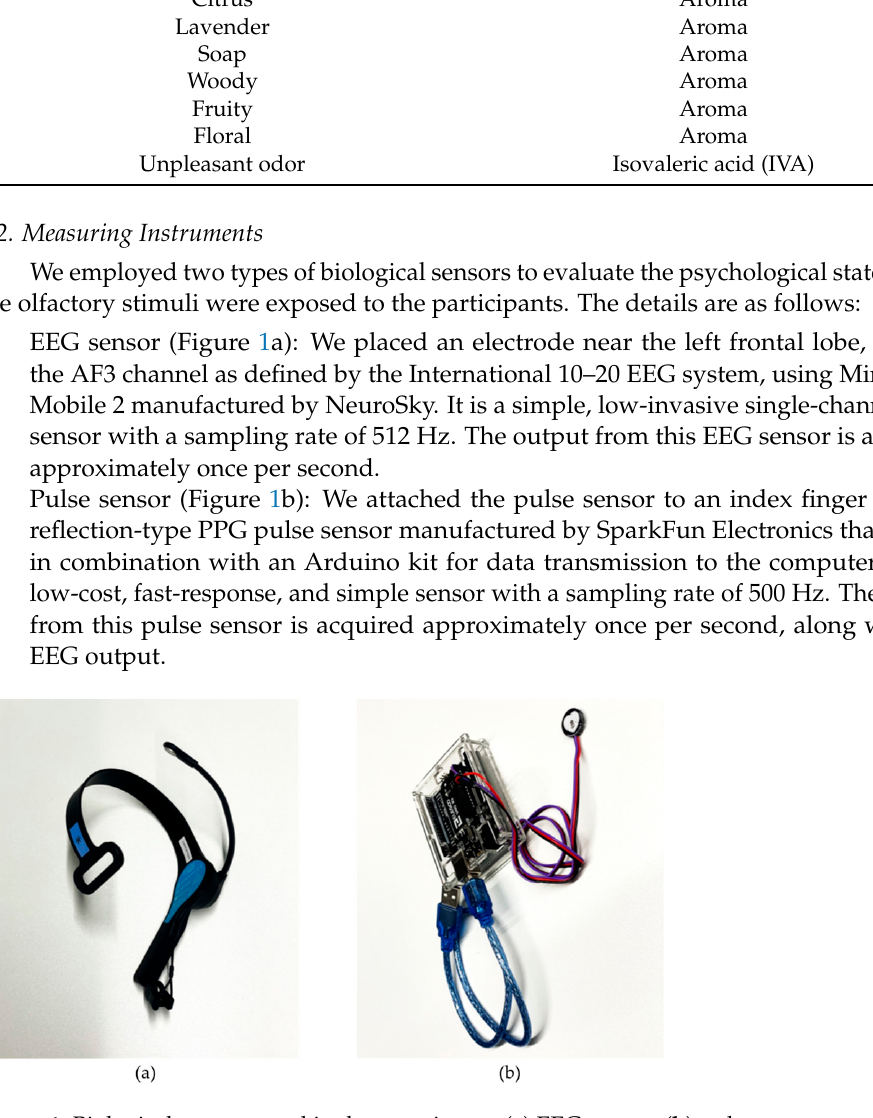
Table 1. Olfactory stimuli used in the experiment.